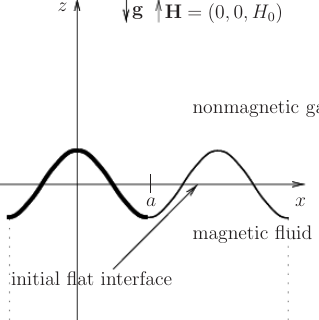
Figure 1. Illustration of the surface